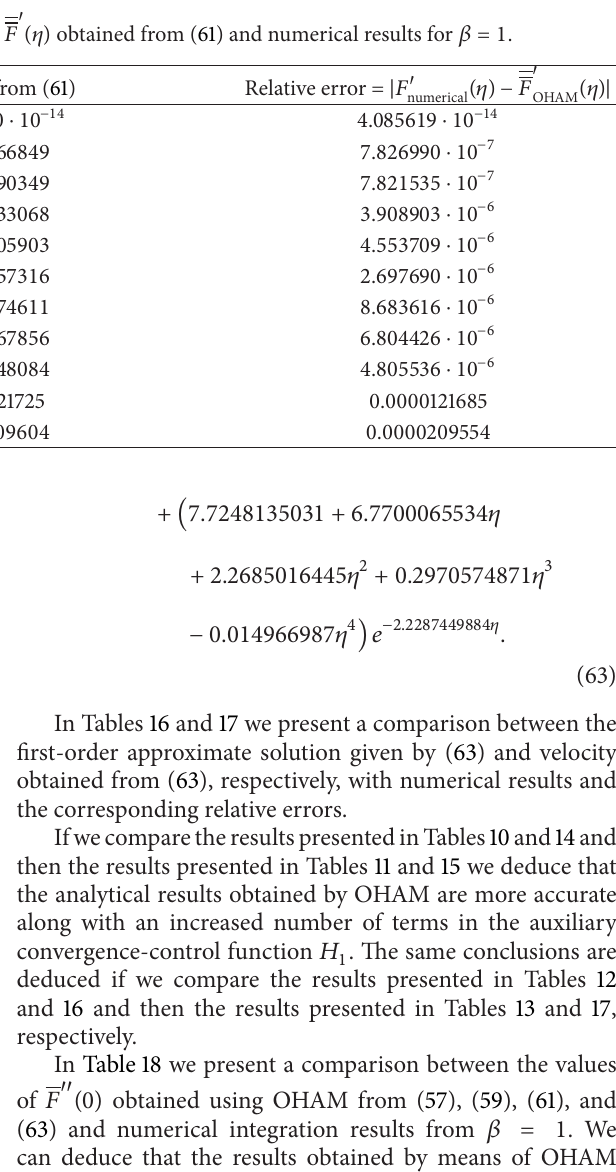
󸀠 (𝜂) obtained from (61) and numerical results for 𝛽 = 1 .